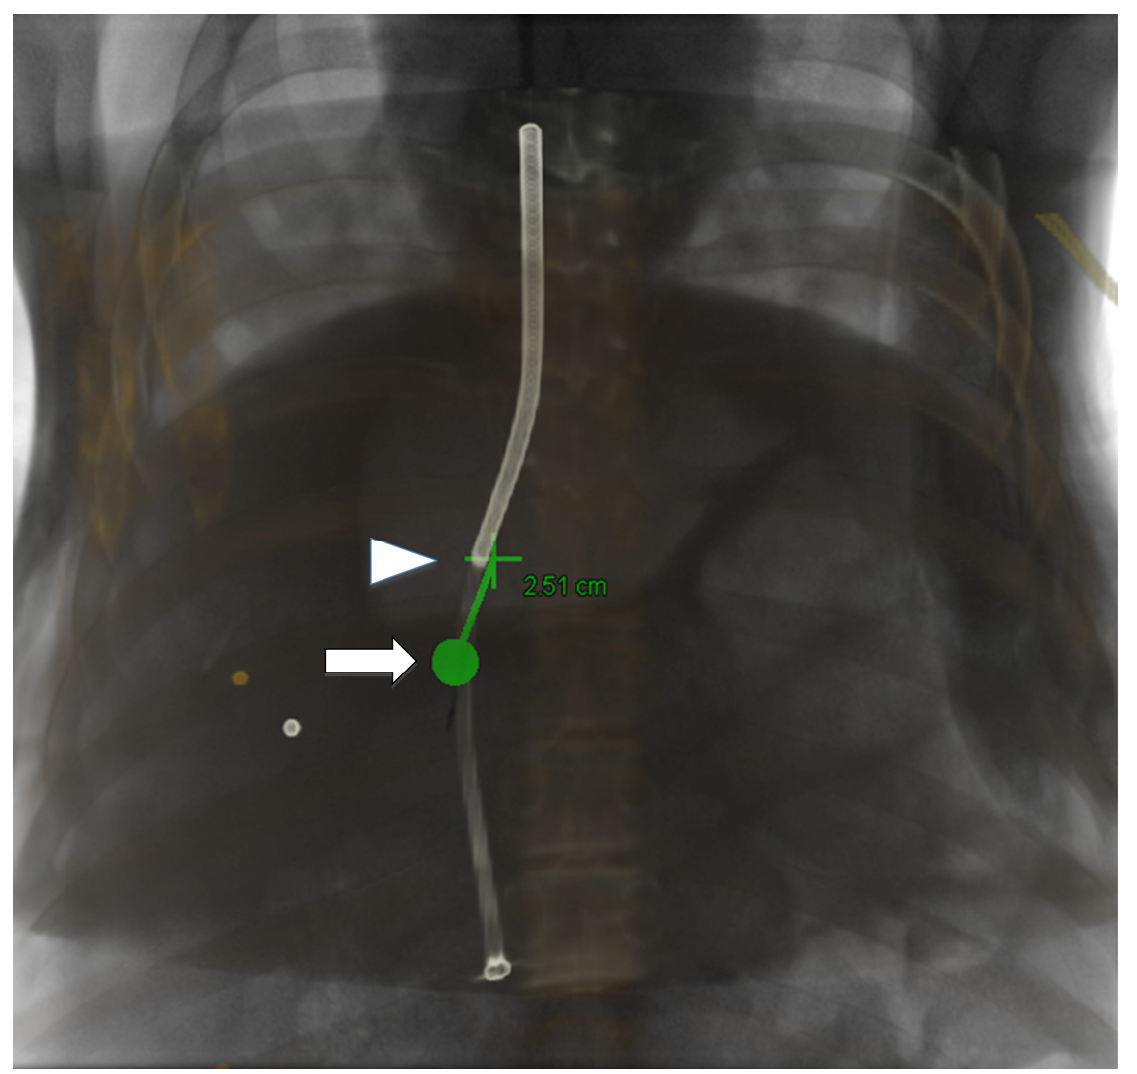
Figure 3. iGUIDE DIPS: a fluoroscopic image of the pre-portal vein puncture for the 3DFIG TIPS procedure using pre-procedural CT and peri-procedural cone beam CT images, demonstrating the virtual path (green) of the portal vein puncture, the location of the needle tip in the IVC (white arrowhead) with the expected distance of puncture and the expected location of the portal vein (white arrow). As expected, the expected distance from the IVC to the portal vein was very short for the DIPS procedure.